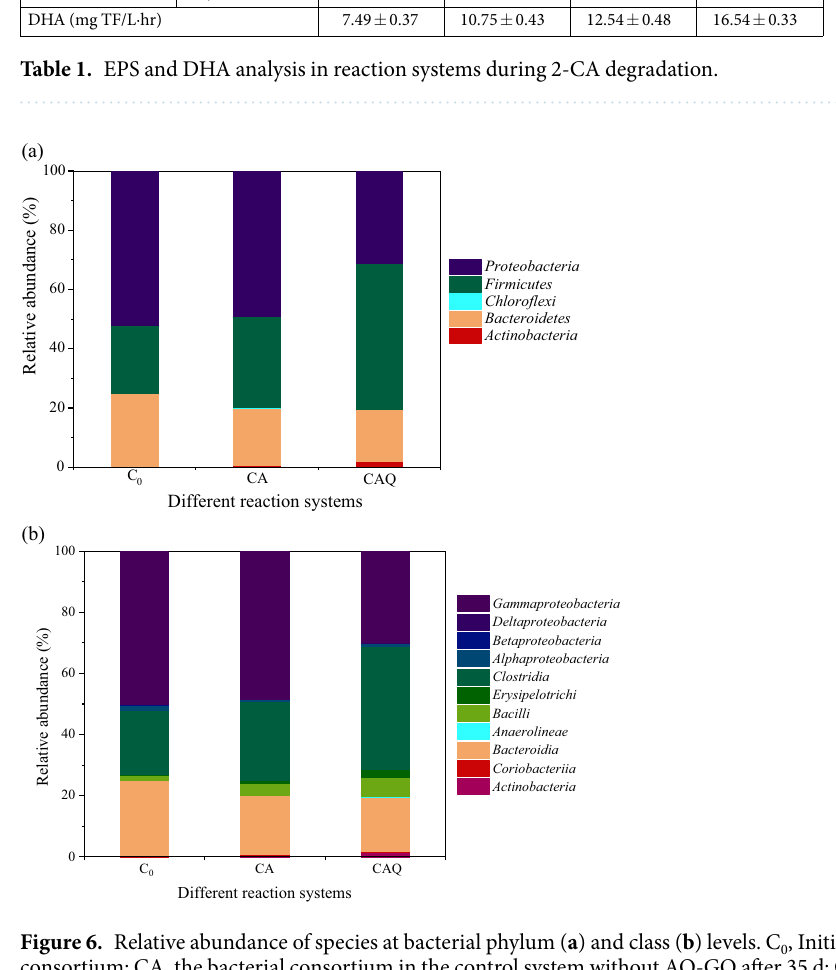
Figure 6. Relative abundance of species at bacterial phylum ( a ) and class ( b ) levels. C 0 , Initial bacterial consortium; CA, the bacterial consortium in the control system without AQ-GO after 35 d; CAQ, the bacterial consortium in AQ-GO supplemented system after 35